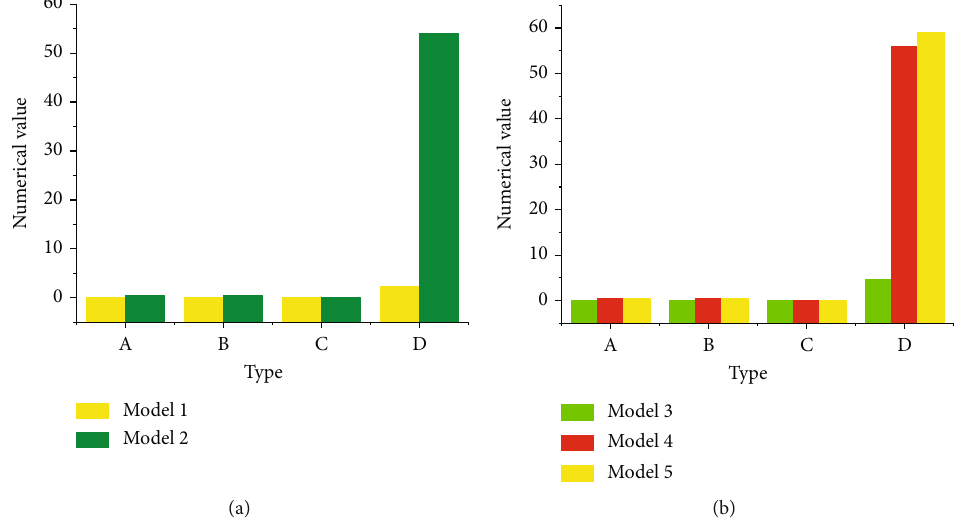
Figure 12: Test results of the mediating e ff ect of leader narcissistic organizational identi fi cation ((a) employees ’ mental health and (b) employees ’ emotional contagion perception. A: R 2 ; B: adjusted R 2 ; C: R 2 variable; and D: F